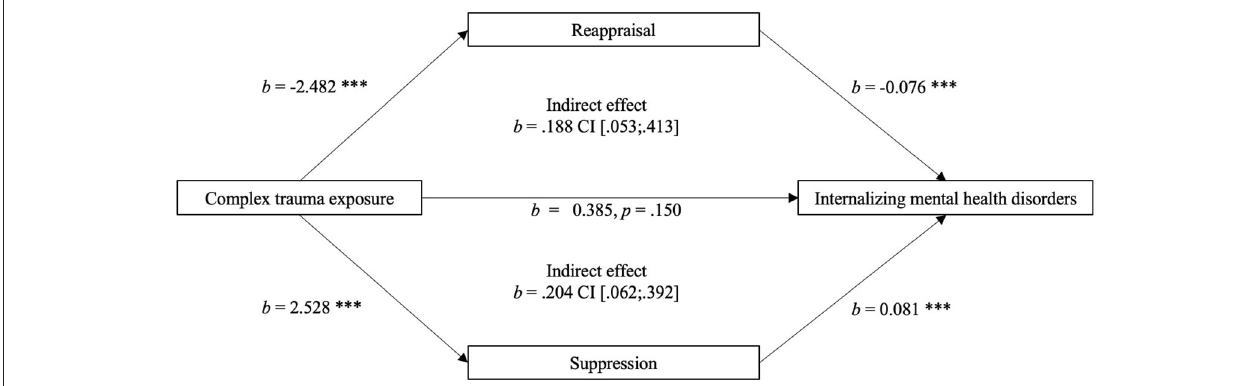
FIGURE 1 | Parallel mediation model of the relationship between complex trauma exposure (Predictor) and internalizing mental health disorders (Outcome Variable), significantly mediated by emotion suppression and reappraisal (Mediators); with age and number of lifetime trauma as covariates.